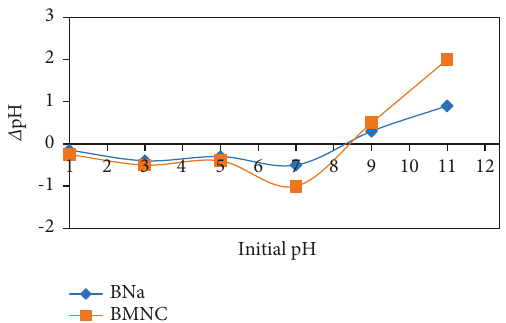
Figure 1: pH-dependent zero charges of bentonite (BNa) and the nanocomposite adsorbent